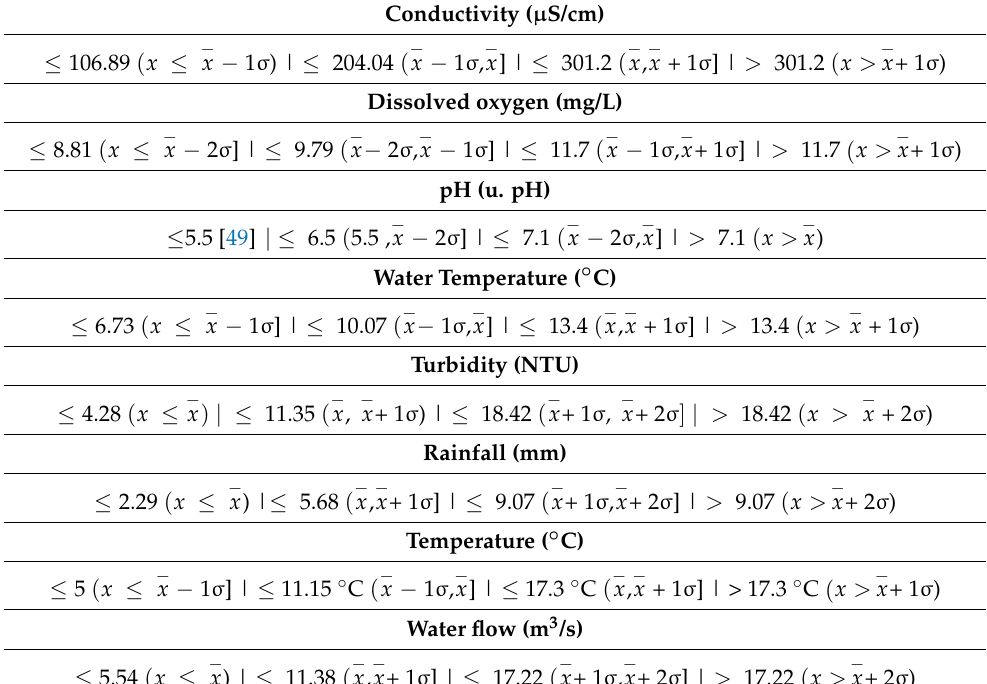
− x control chart